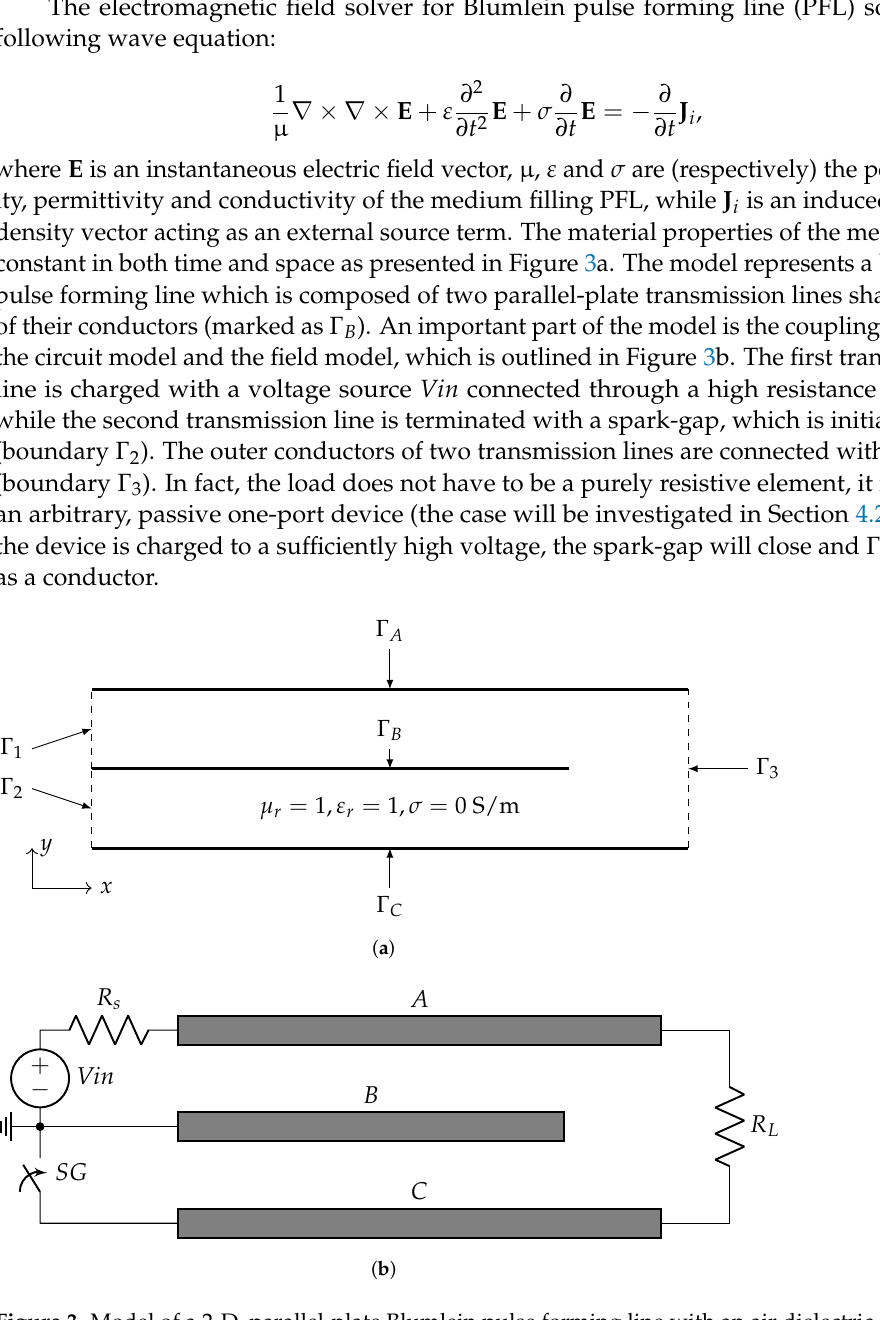
Figure 3. Model of a 2-D, parallel-plate Blumlein pulse forming line with an air dielectric. The solid black lines are perfect electric conductors (zero Dirichlet boundary condition), while the dashed lines are perfect magnetic conductors (default, natural Neumann boundary condition). ( a ) Model of the field simulation (not to scale). ( b ) Coupling between the circuit and field models (conductors A , B and C correspond to the boundaries Γ A , Γ B and Γ C from the field direction of flow as it would imply a zero-crossing. When there is not enough current to 162 keep the channel conducting, both ( i 2 d τ ) and t arc are reset to zero and the channel 163 is considered off. 164 R